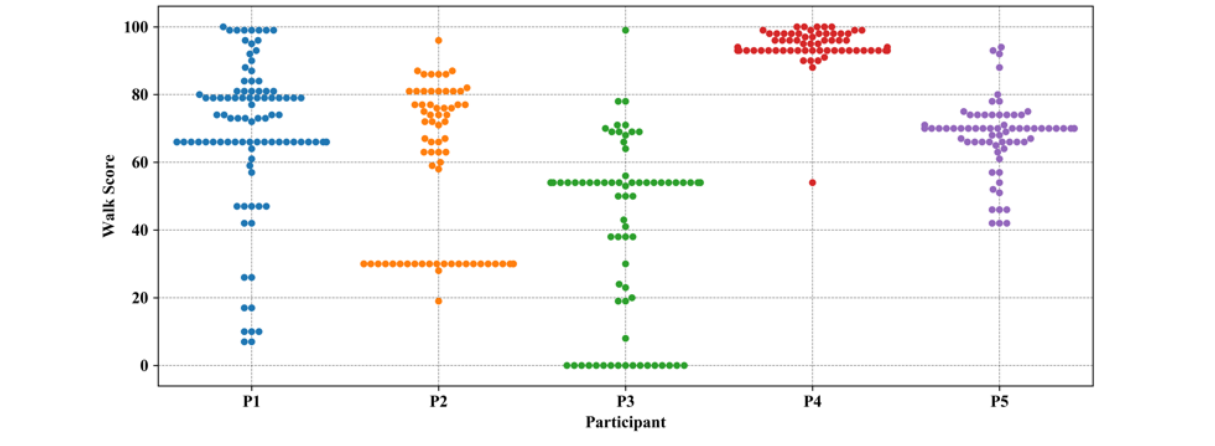
Figure 6. Distribution of Walk Scores of each participant’s (P) destinations, as calculated by Walk Score [38]. A score of 0-24 or 25-49 is considered Car-Dependent, a score of 50-69 is considered Somewhat Walkable, a score of 70-89 is considered Very Walkable, and a score of 90-100 is considered Walker's Paradise.